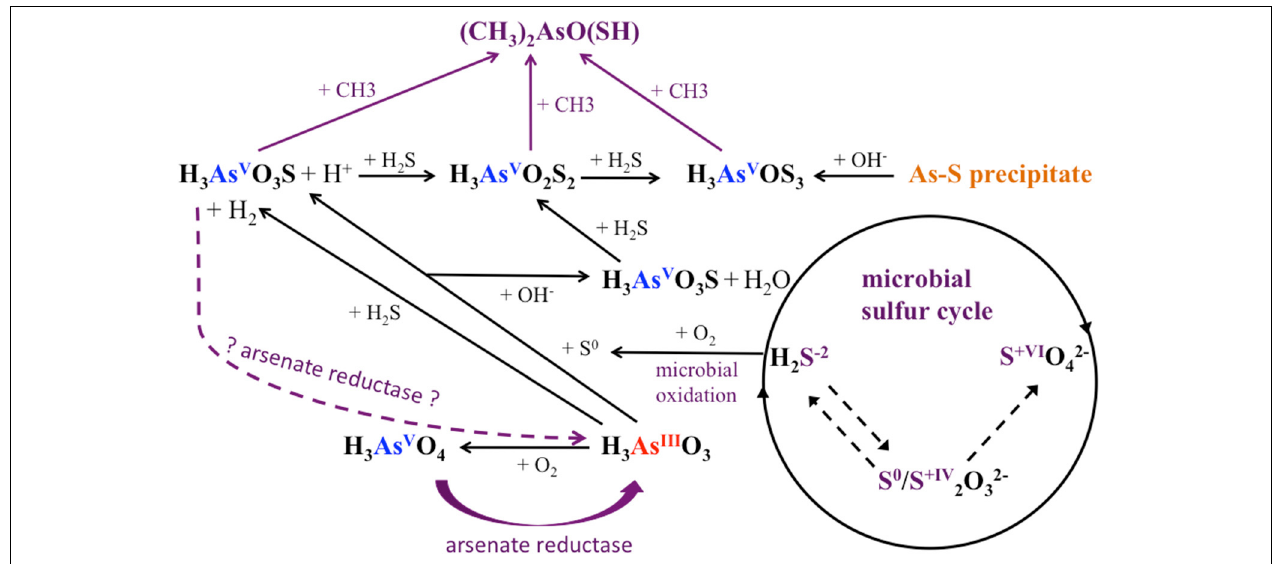
FIGURE 8 | Arsenic and sulfur cycle influenced by microorganisms in Champagne Pool. H 3 AsO 3 , arsenite; H 3 AsO 4 , arsenate; H 3 AsO 3 S, monothioarsenate; H 3 AsO 2 S 2 , dithioarsenate; H 3 AsOS 3 , trithioarsenate; (CH 3 ) 2 AsO(SH), dimethylmonothioarsenate. purple: biotic